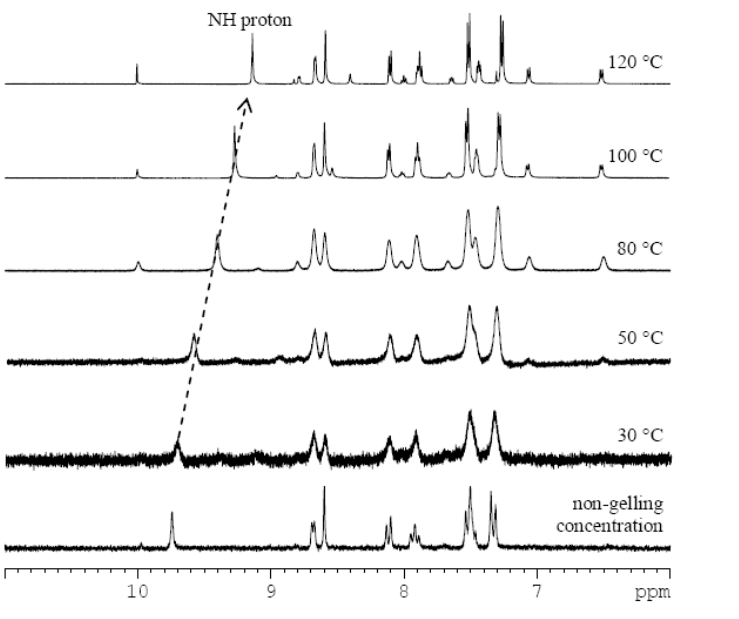
Figure 2. 1 H-NMR subspectra of imine 3 in DMSO- d at non-gelling concentration 6 (0.2% w/v), and as a DMSO- d gel (2.5% w/v) at different temperatures (30–120 °C) with a 6 highlighted shift of the amide proton signal (dotted